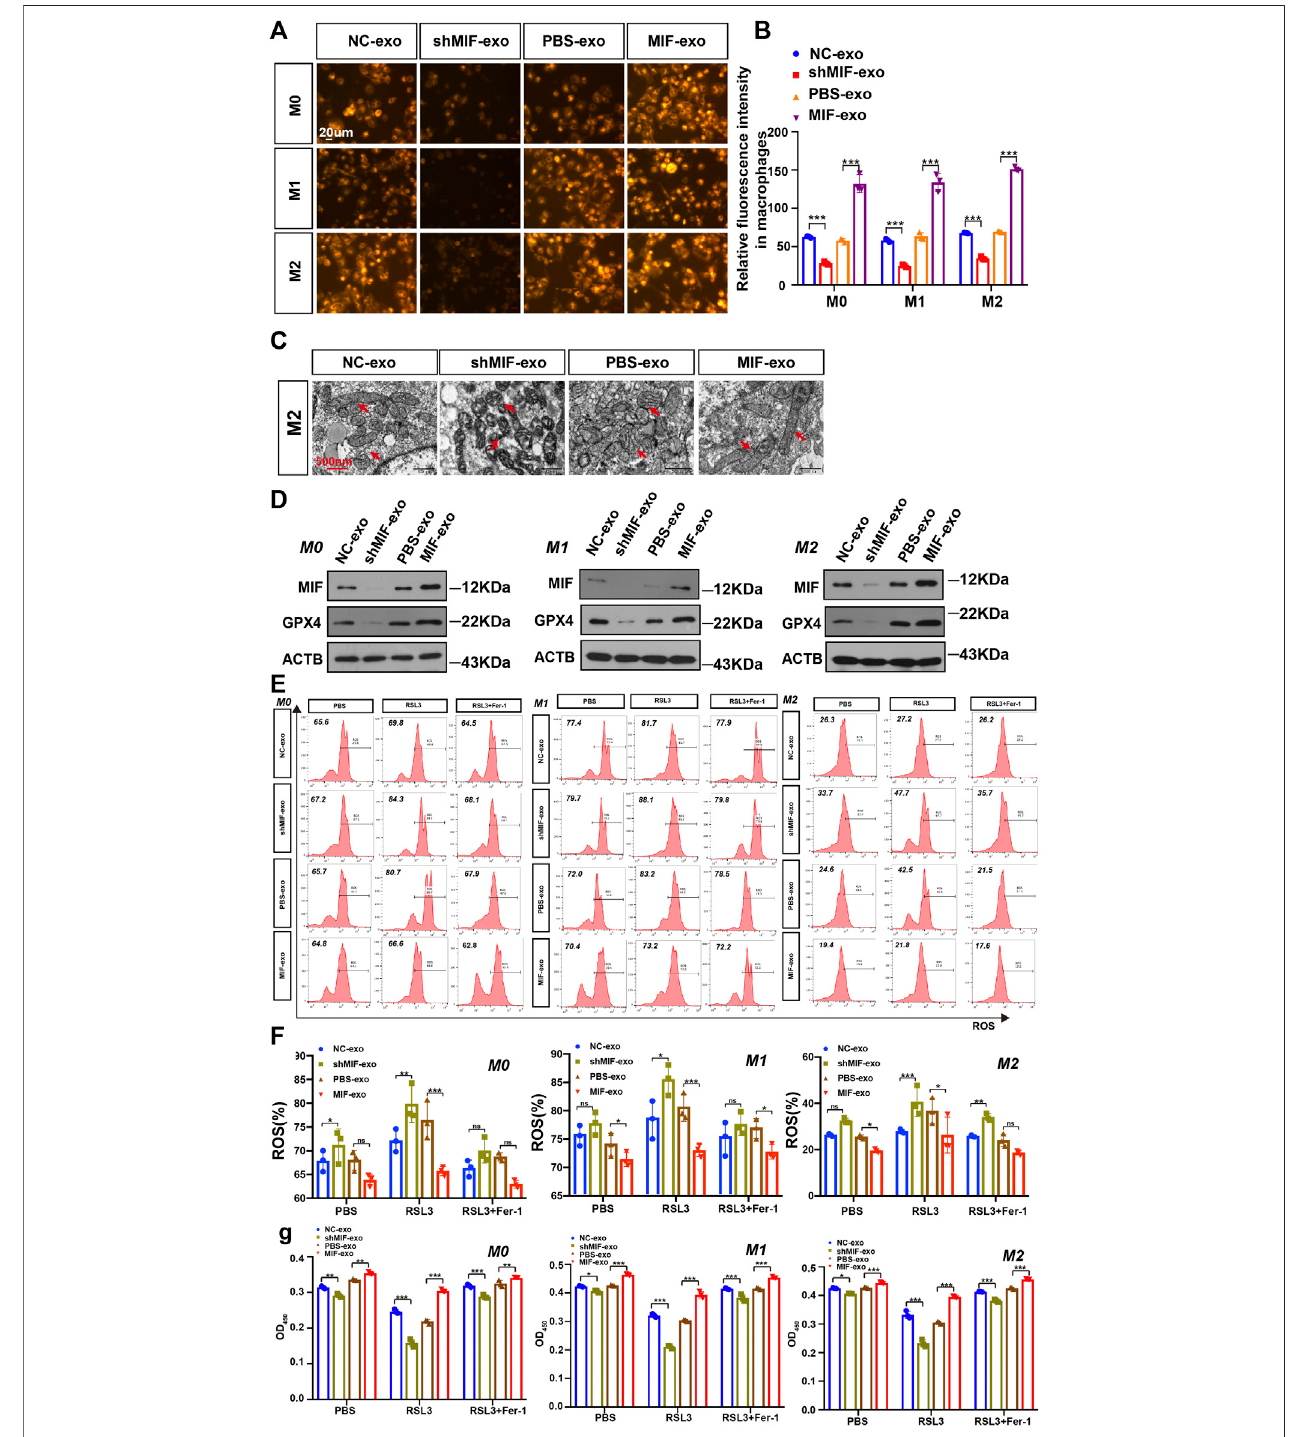
FIGURE 6 | Exosomal MIF inhibits ferroptosis of macrophages in vitro . (A) FerroOrange experiment involving staining of divalent iron in macrophages. Scale bar: 20 um. (B) Statisticalanalysisofthe fl uorescenceintensityofferrousiron. (C) Representativetransmissionelectronmicroscopy(TEM)imagesofM2macrophages.Scale bar:500 nm. Red arrows indicate mitochondria. (D) WB analysis of the relationship between GPX4 and MIF expression levels in M0, M1 and M2 macrophages. (E,F) Flow cytometry ofROSinmacrophages (Two-way ANOVA). (G) Celldeathwasestimated byCCK8 assay(Two-wayANOVA).Allgraphsshowthe mean ± SEMof at least three independent experiments. * p < 0.05, ** p < 0.01, *** p < 0.001.